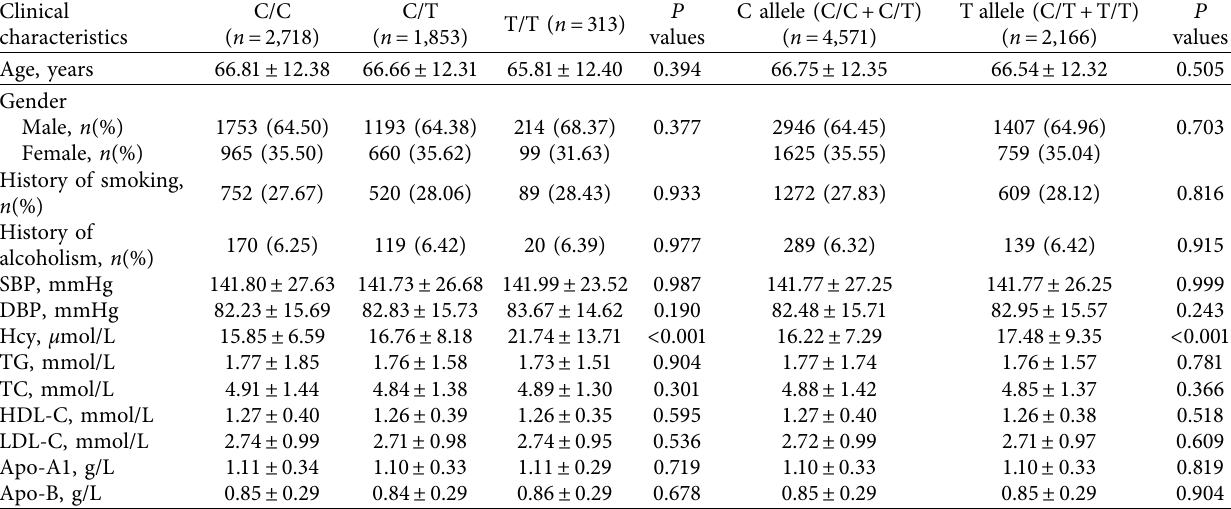
Table 4: Clinical characteristics of subjects stratified by MTHFR rs1801133 genotypes and alleles.